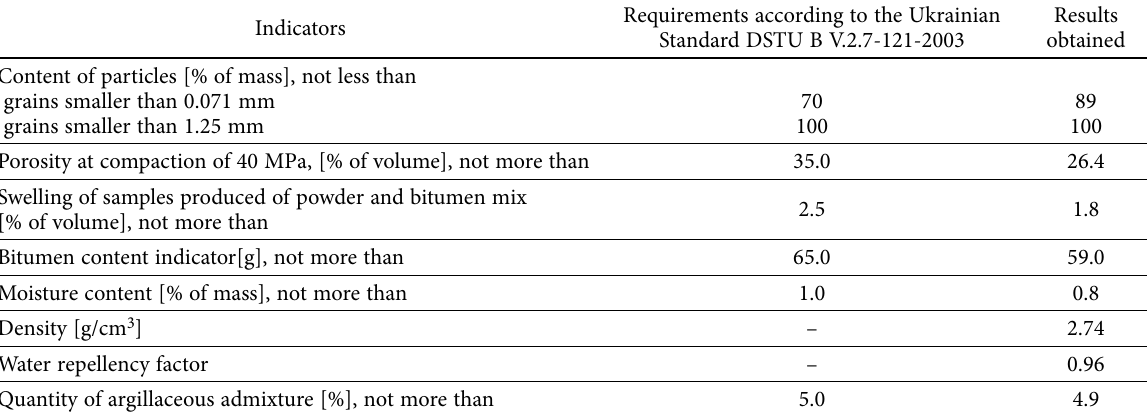
Table 6. Physical and mechanical properties of mineral powder produced from electric steel-smelting slag Indicators